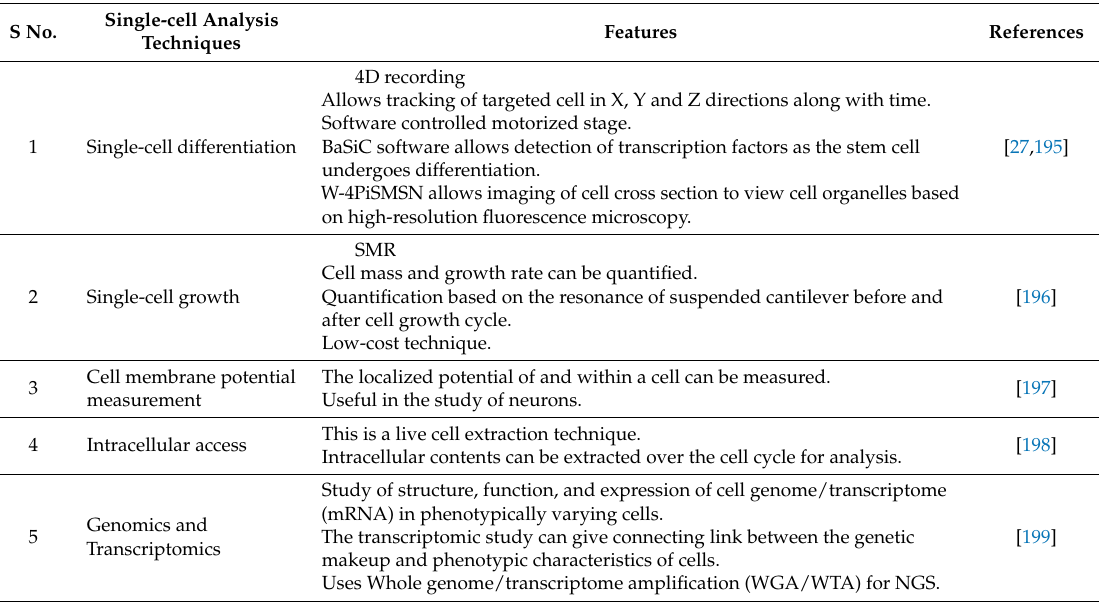
Table 4. Single-cell analysis techniques.